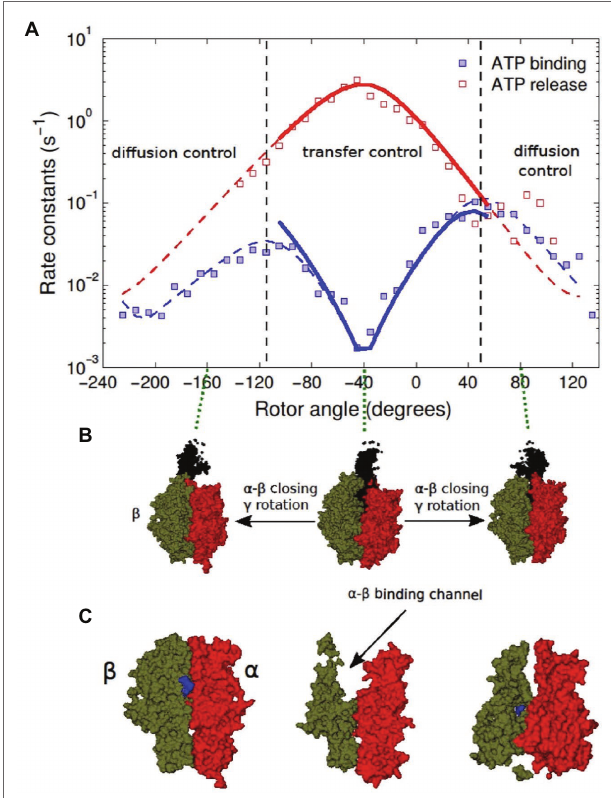
FIGURE 5 | (A) Reported binding and release rate constants vs. controlled rotation angle for fluorescent ATP in the presence of Pi in solution. The reported uncorrected experimental data (squares) are compared with theoretical counterparts (solid lines) by calculating missed events and also correcting for an error due to replacing the time in the empty state T 0 by the total time T. Dashed lines show a fit to the experimental data. (B) F 1 -ATPase structure at three different rotor angles with β subunits in green, α subunits in red and the γ subunit in black. (C) Cutaway of the three structures (PDB:1H8E) revealing the binding channel at the α − β interface and its narrowing as the rotor angle is changed. The figure was reproduced with permission from Volkán-Kacsó and Marcus